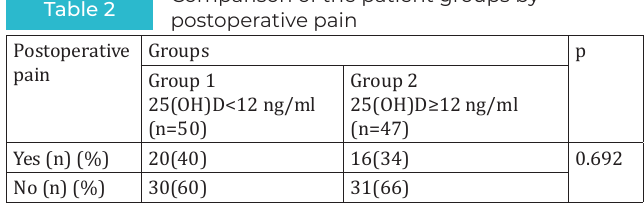
Comparison of the patient groups by postoperative pain